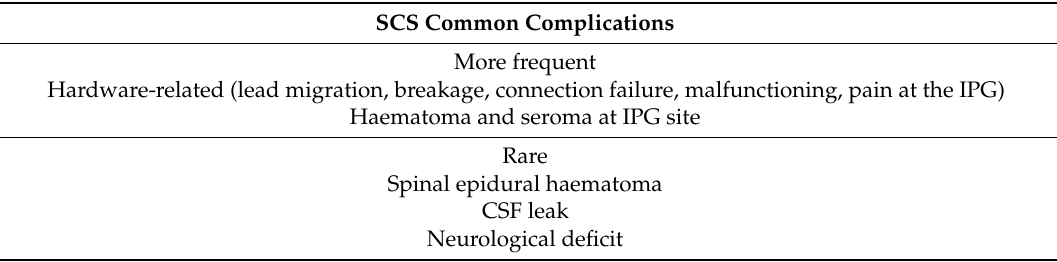
Table 2. SCS surgical